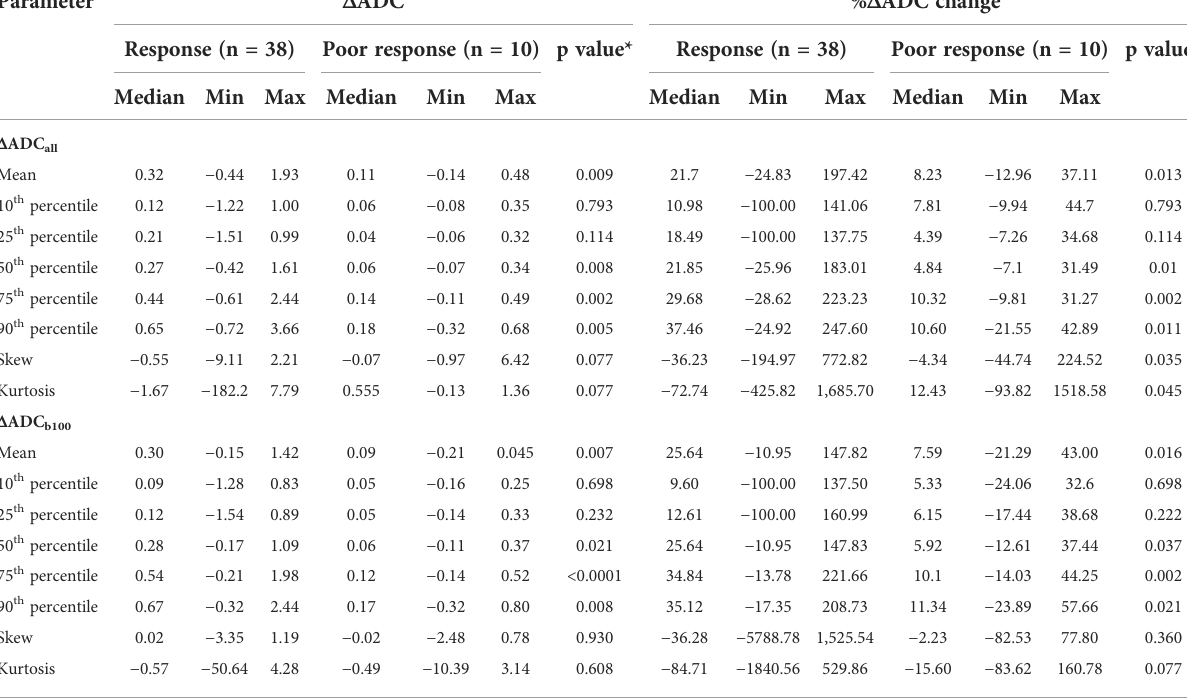
TABLE 2 Change in ADC histogram parameters to neo-adjuvant chemotherapy as grouped by conventional response assessment. Parameter D ADC % D ADC change